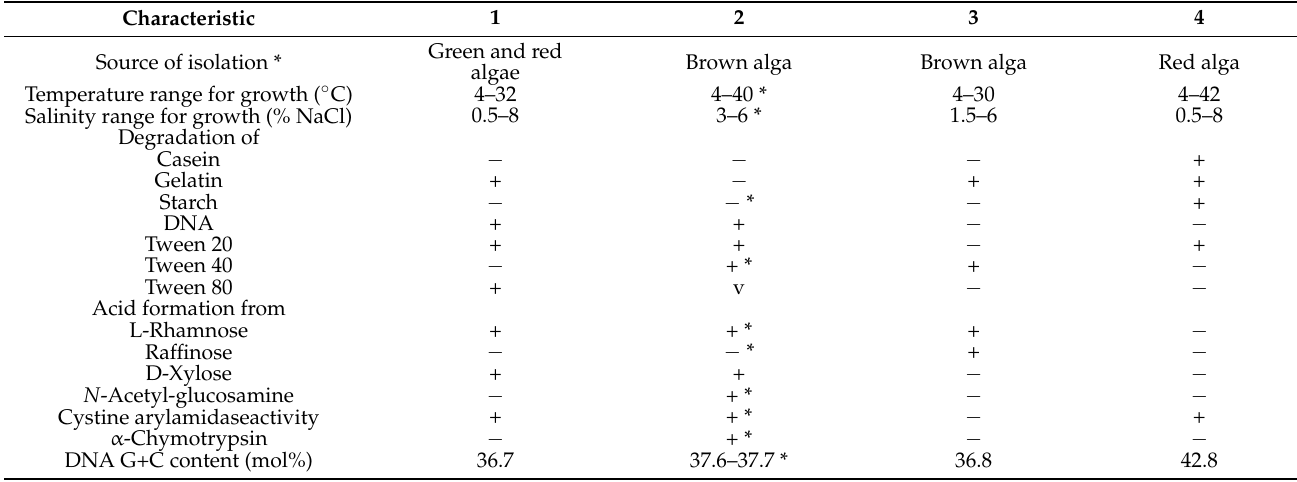
Table 2. Phenotypic characteristics, differentiating six alga-associated isolates and closely related species of the genus Zobellia .